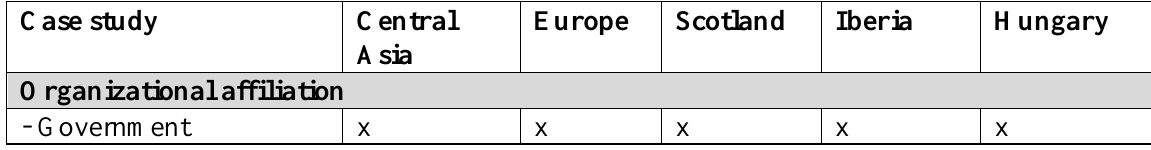
Table A1: overview of stakeholder selection criteria for each case